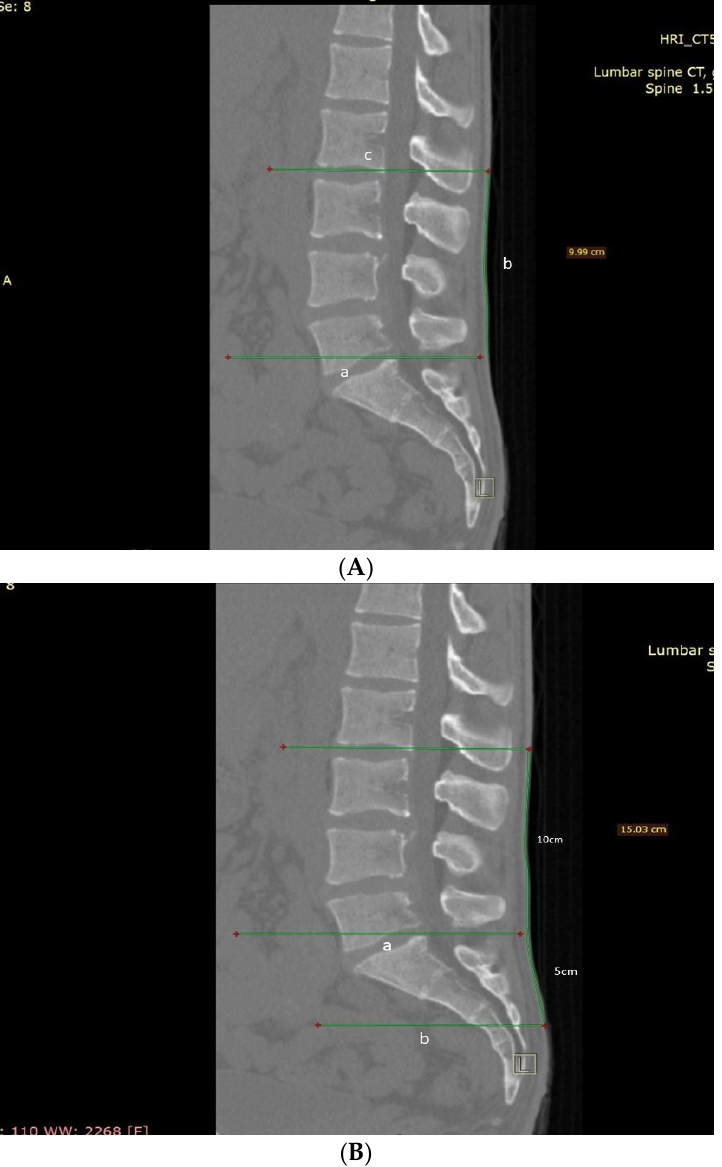
Figure 1. ( A ) Schober Test CT measurement. A parallel line is drawn from the posterosuperior corner of the S1 vertebra to the skin (marked as a), which is followed by a 10 cm line drawn over the skin to reach the cephalad endpoint imitating the original Schober test (marked as b). A parallel line was drawn from this point to the skeletal spine level, transecting a vertebra (upper third, middle third, or lower third) or a disc space (marked as c). Lumbar vertebrae were numbered as (L)1 to (L)5, with the upper third as 0.3, middle third as 0.6, and lower third as 0.9. A line transecting the middle third of L2 was therefore designated as 2.6. Sacral vertebras were numbered from 6 to 10 similarly. ( B ) Modified Schober Test CT measurement. It was measured similarly to the Schober test by marking a skin point 5 cm caudal and 10 cm cephalad to the lumbosacral junction (a parallel line drawn from the posterosuperior corner of the S1 vertebra to the skin) (Marked as a). Spinal endpoints were measured; the cephalad point was measured as in the Schober test. The caudal end was measured as the parallel line from the caudal 5 cm skin point to the skeletal spine level (upper third, middle third, or lower third of a vertebra or the disc space) (Marked as b).